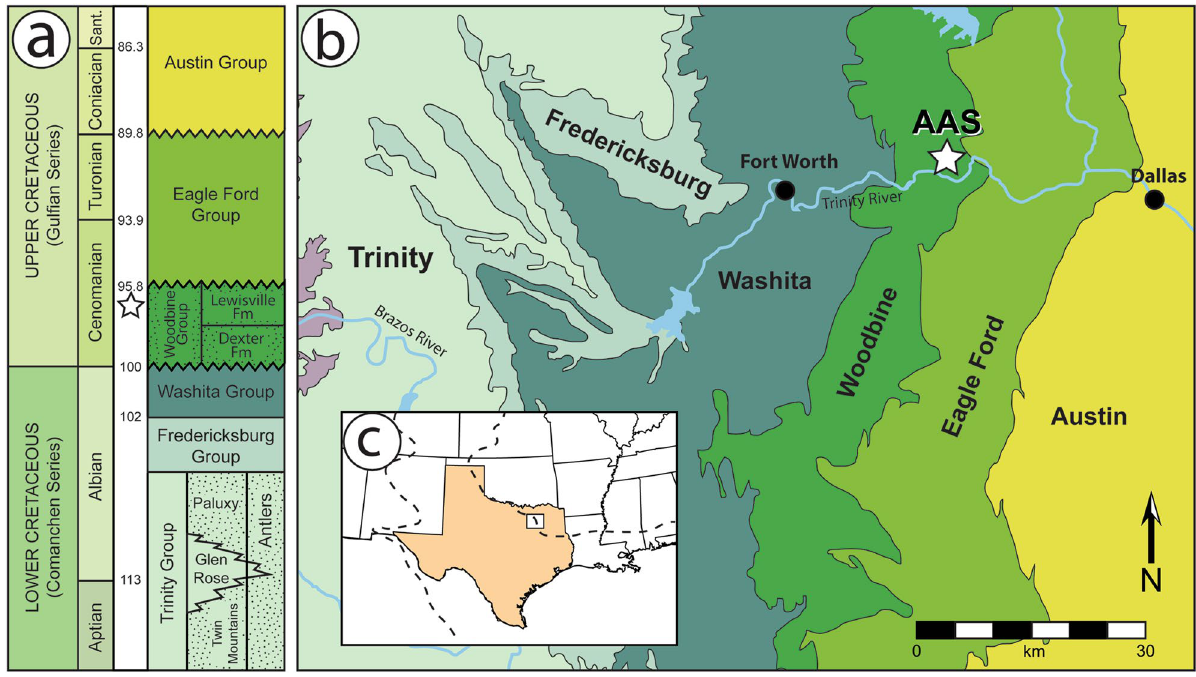
Figure 1. Location and geologic setting of the Arlington Archosaur Site (AAS marked with star). ( a ) Stratigraphic column and selected ages of Cretaceous rock units in north-central Texas, using stratigraphic nomenclature for the Woodbine Gp from Denne et al. 26 . Terrestrial deposits indicated by stippled patterns. Modified from Winkler et al. 27 and Jacobs et al. 28 ; ( b ) Generalized map of geologic units in the Fort Worth Basin; ( c ) Inset map showing approximate location of the AAS in relation to the southern Western Interior Seaway [WIS] (modified after Barnes et al. 29 and Strganac 30 ). Approximate WIS shorelines during the Cenomanian are dotted (after Blakey 31 ). Figure created with Photoshop CS5 (Adobe